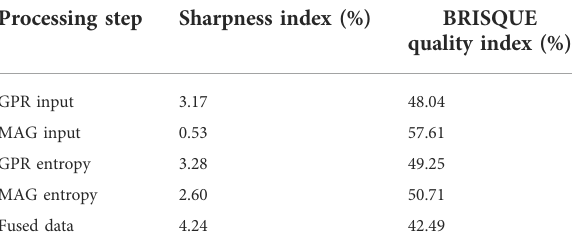
TABLE 3 Sharpness index and BRISQUE quality index of sector A1 data at several processing stages. Processing step